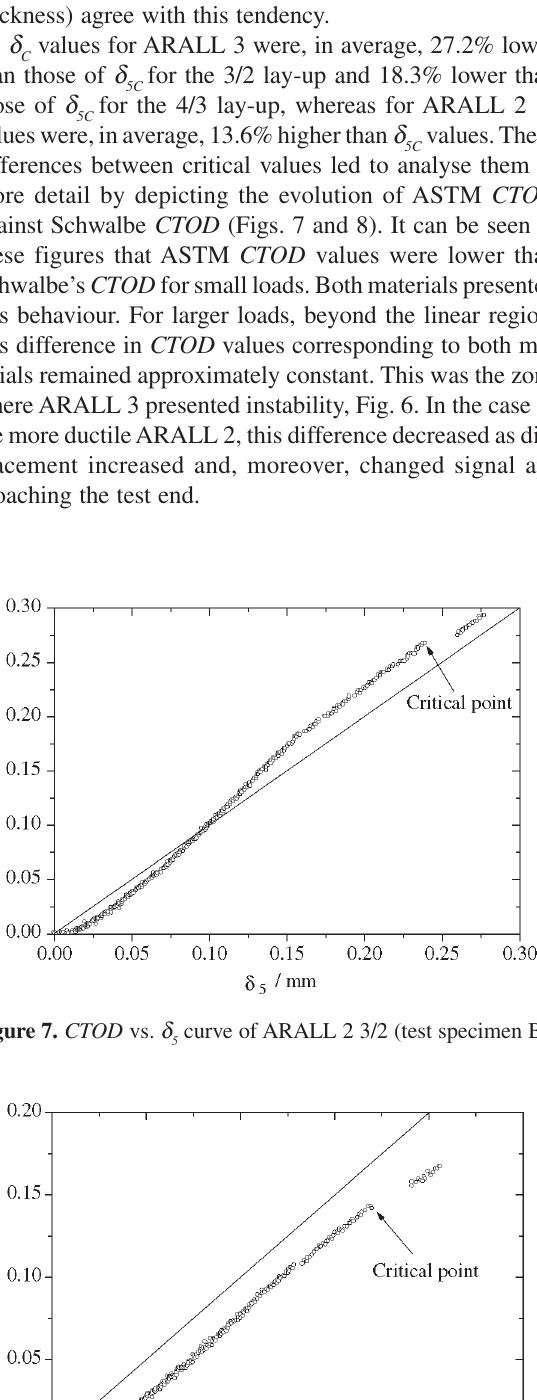
Table 3. Mean and standard deviation values of the results in Ta- ble